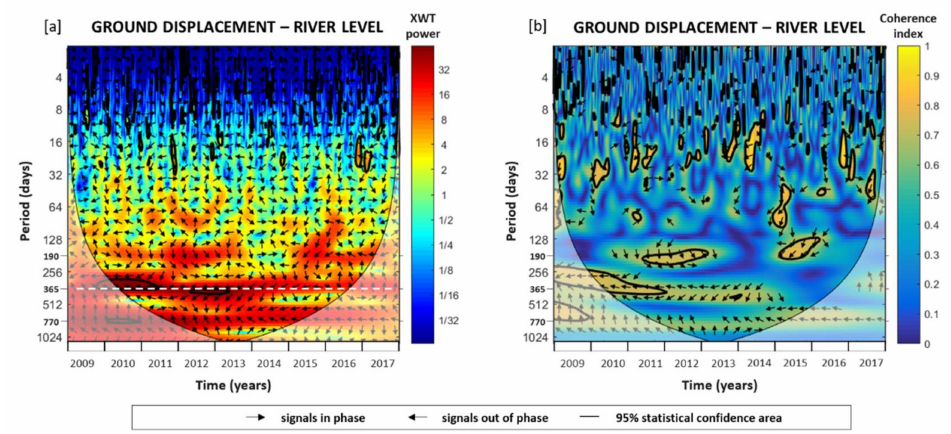
Figure 7. ( a ) Cross wavelet transform (XWT) and ( b ) wavelet transform coherence (WTC) between CODI CGPS data and Po di Goro level at Ariano SIAP hydrometric station. The thick black contour designates the 95% significance level against red noise, while the black contoured shading is the cone of influence where edge e ff ects occur. White dashed line indicates the result of cross-correlation with respect to the annual periodicity of the two signals.